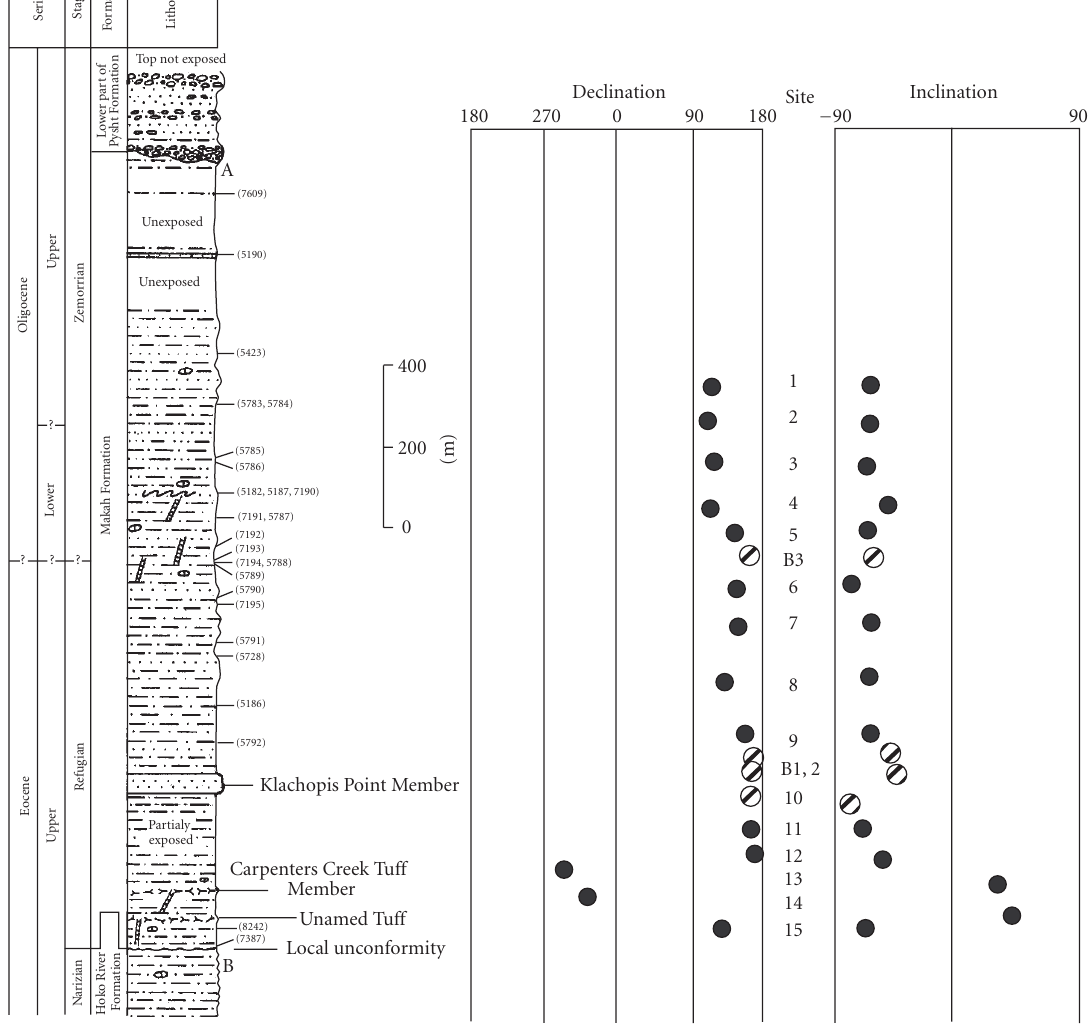
Figure 7: Magnetic stratigraphy of the Ozette Road-Hoko River section. Conventions as in Figure 6. Modified from Snavely et al. [8, Figure